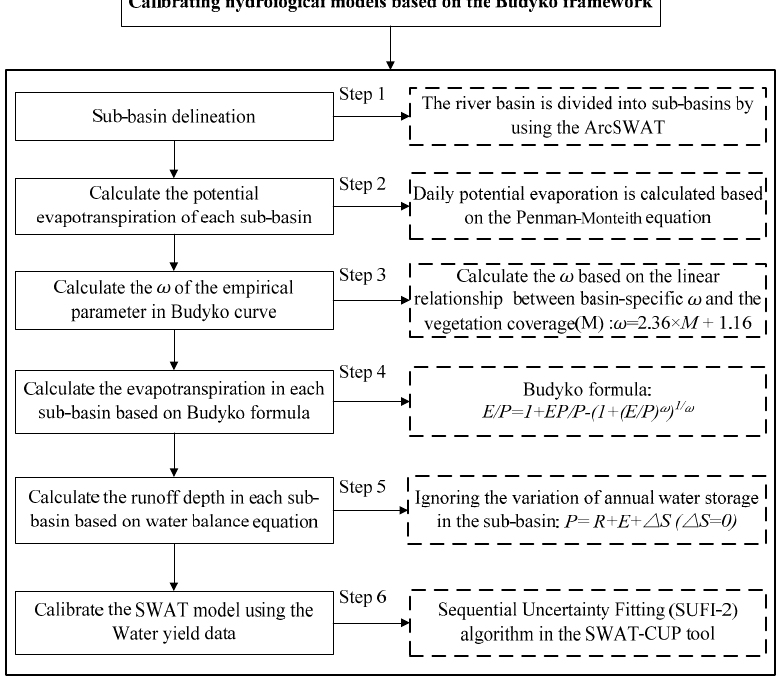
Figure 3. Flowchart of calibrating SWAT model based on Budyko framework.